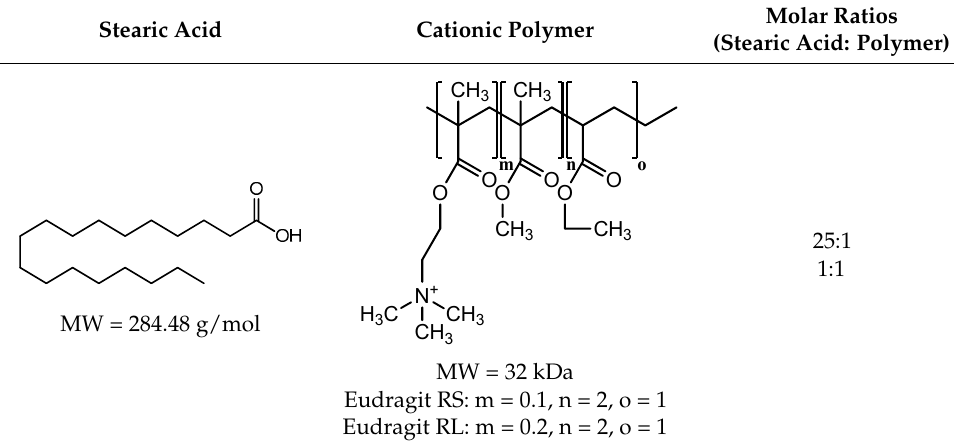
Table 1. Hydrophobic ionic complexes of stearic acid with selected cationic polymers. Stearic Acid Cationic Polymer